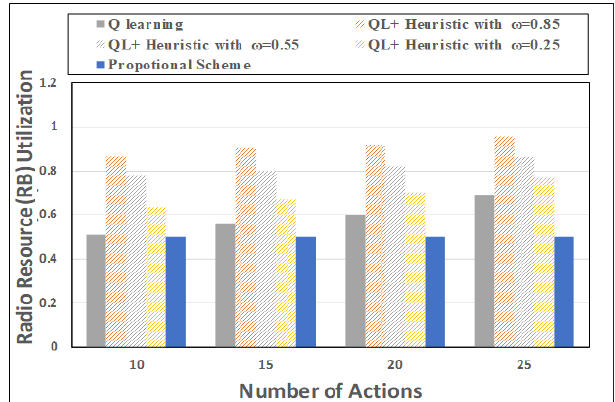
Figure 2. Uplink RB utilization as a function of the Number of Actions.